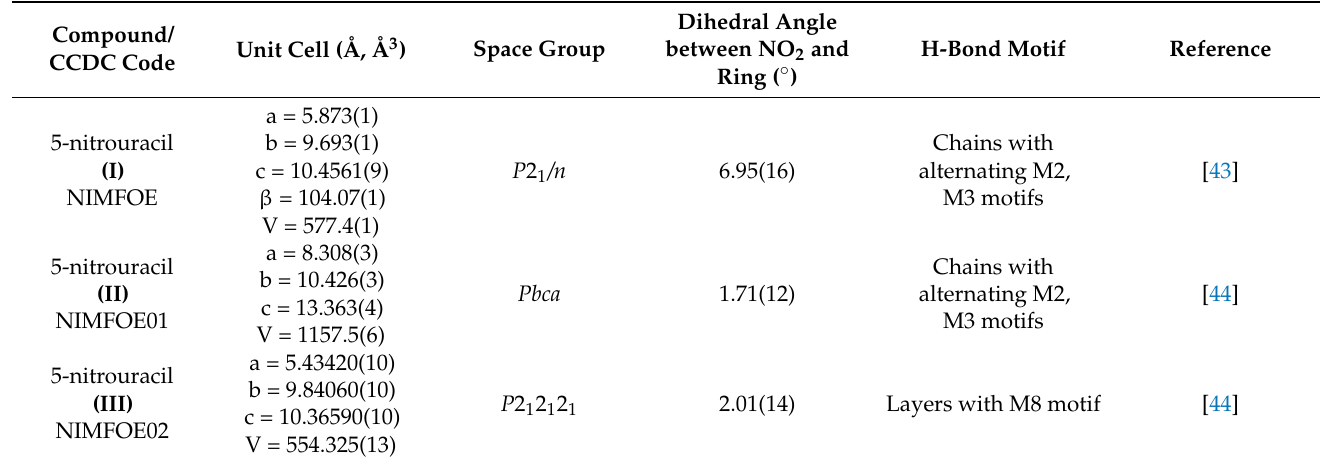
Table 2. Crystallographic data of 5NU